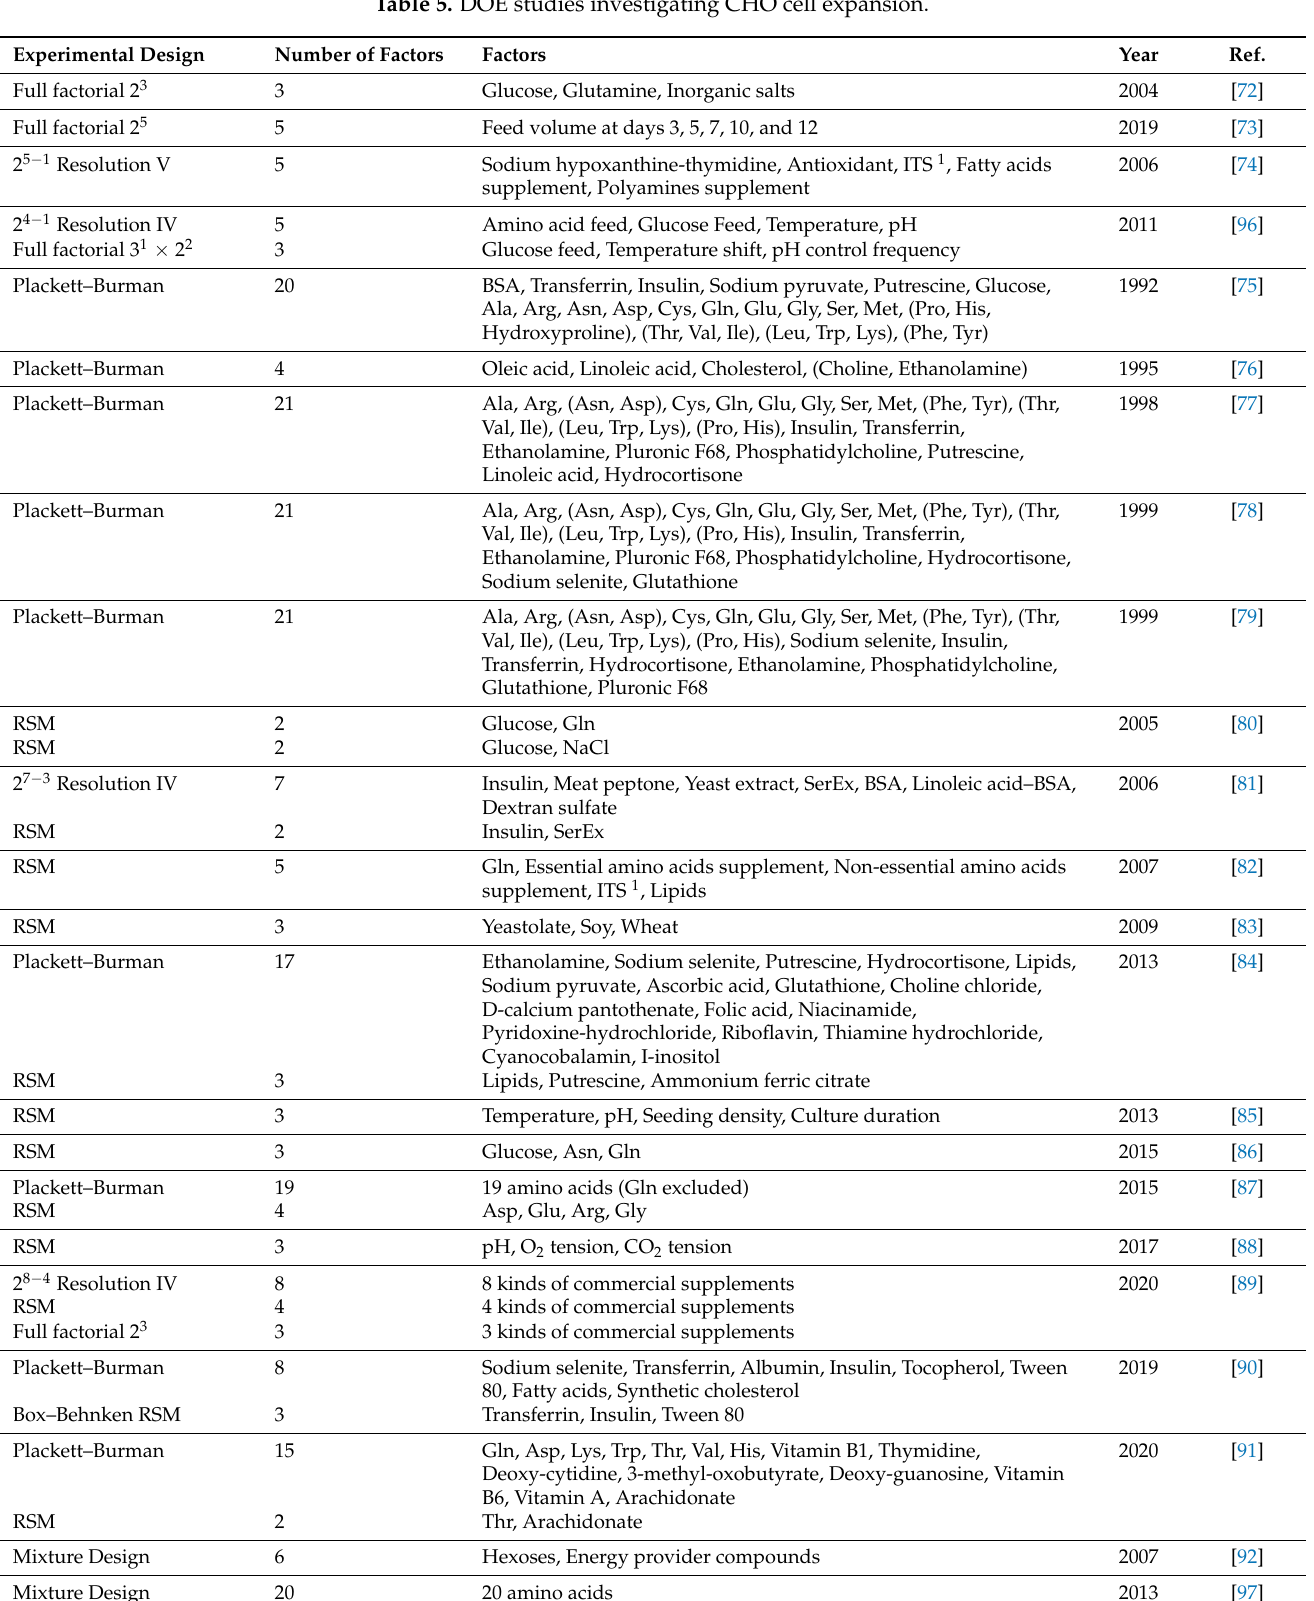
Table 5. DOE studies investigating CHO cell